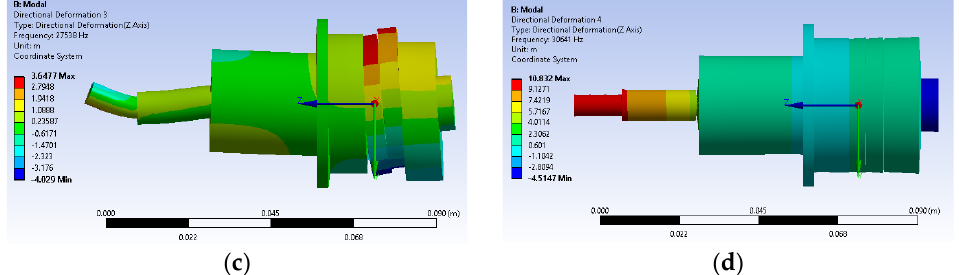
Figure 5. Mode shapes from FE modal analysis for T1; ( a ) Mode 1; ( b ) Mode 2; ( c ) Mode 3; and ( d ) Mode 4.